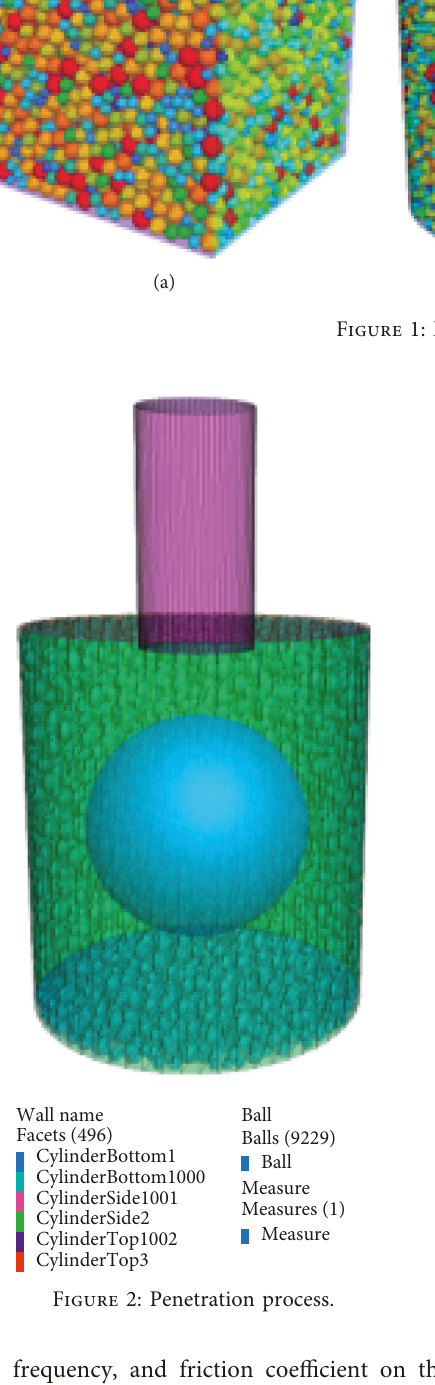
Figure 2: Penetration process.